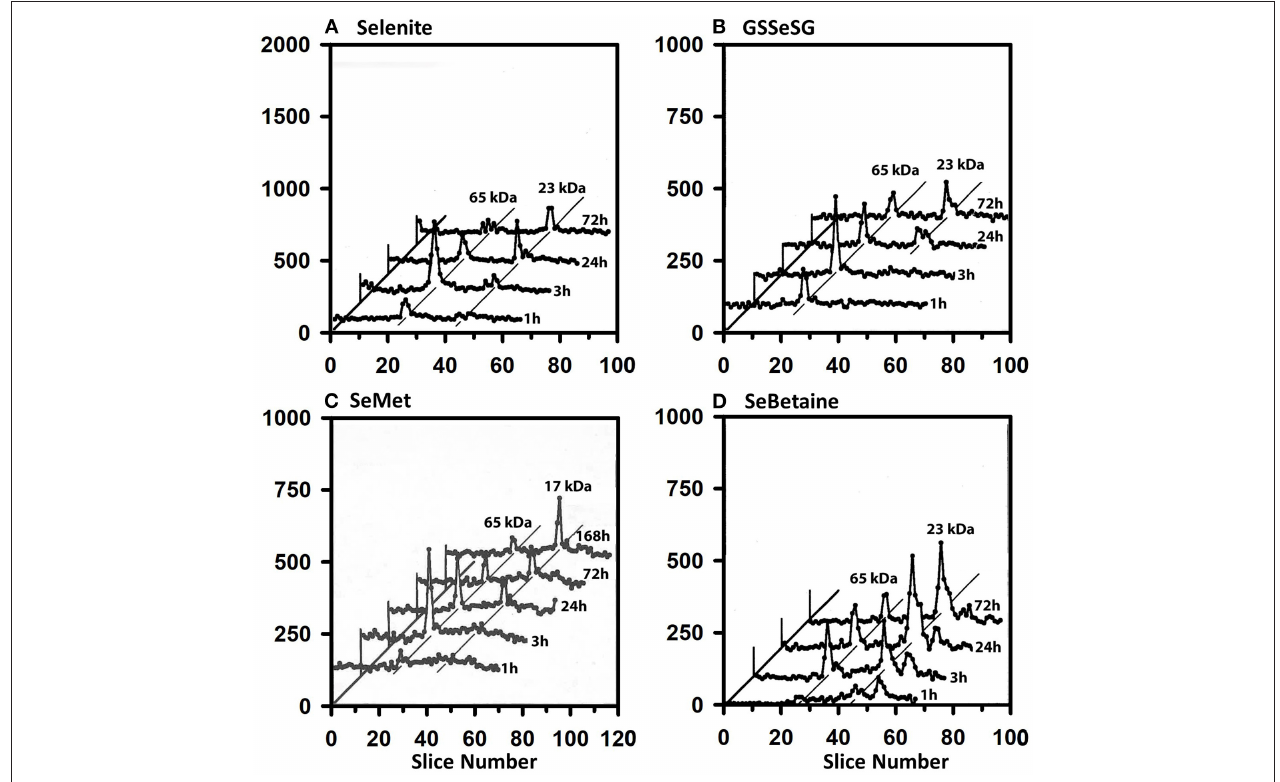
FIGURE 5 | Incorporation of 75 Se into heart supernatant proteins from Selenite (A) , GSSeSG (B) , SeMet (C) , and SeBetaine (D) . Rats were treated as described for Figure 3 . Heart tissue was homogenized in Tris/SDS and centrifuged at 105,000 x g, and supernatants (1,500 µ g protein) were separated using gradient SDS/PAGE as described for Figure 3 ( n = 17 total rats). GPX1 is 23 kDa, and the 65 kDa species are likely to the isoenzymes of